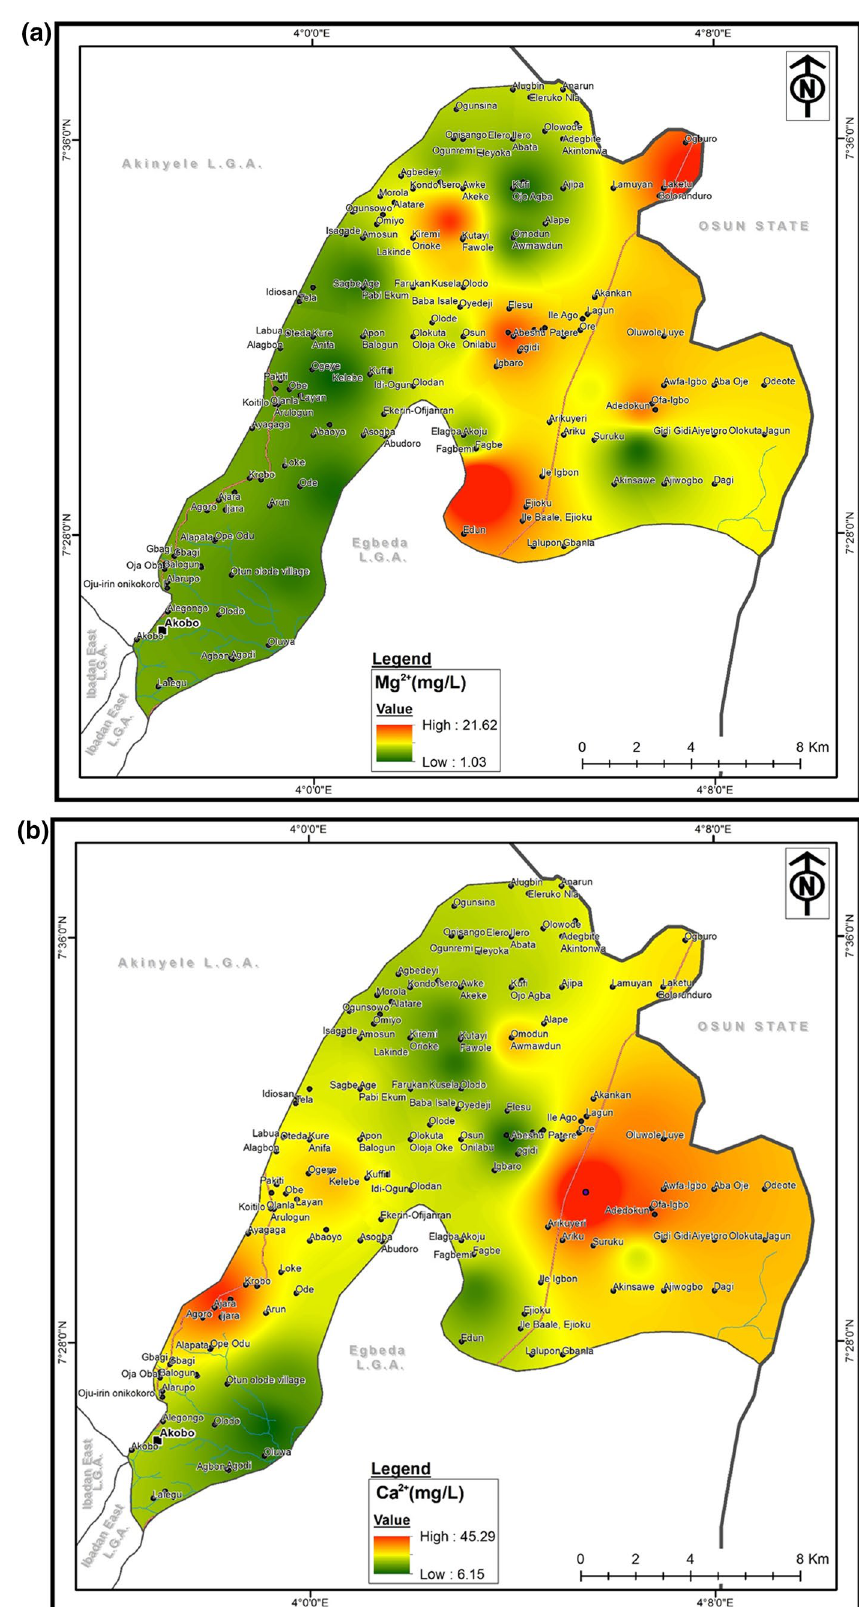
Fig. 3 Spatial disparity maps of a Ca 2+ , b Mg 2+ , c K + and d Na